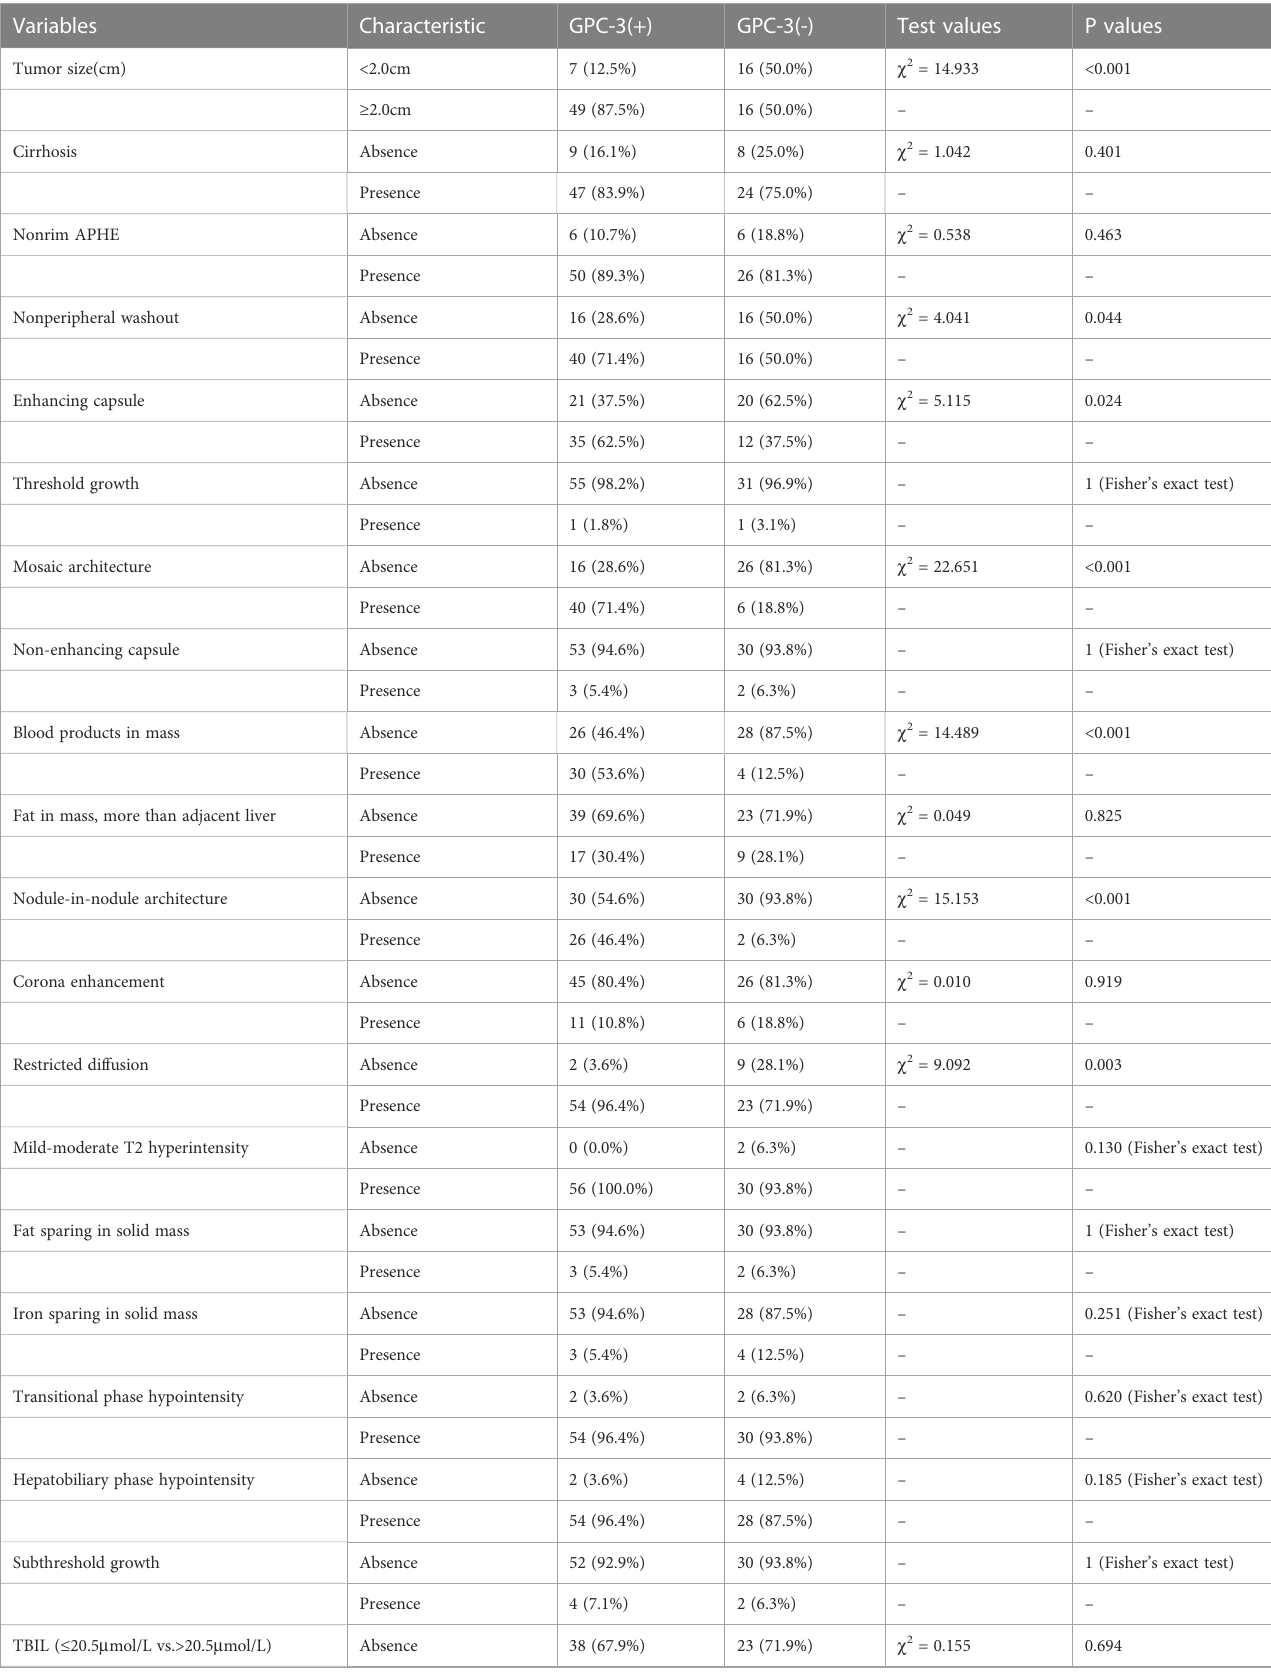
TABLE 3 The univariate analysis between GPC-3 expression with MRI features and clinical factors in training cohort (categorical and dichotomized